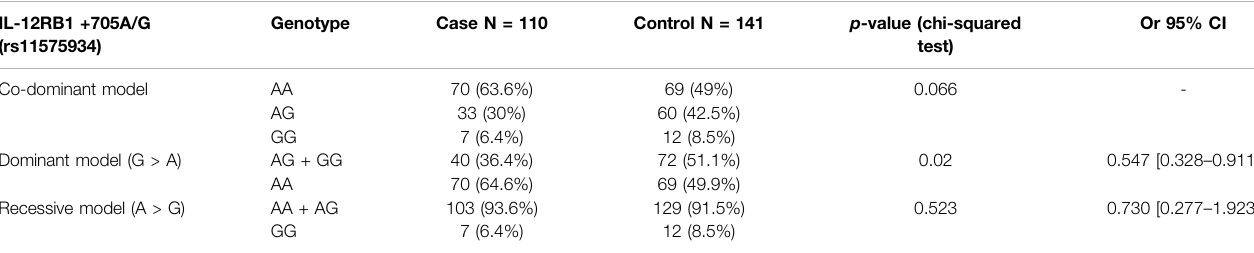
TABLE 4 | Allelic and genotypic distributions of the IL-12RB1+705 A/G polymorphism in patients with CRC and controls. IL-12RB1 +705A/G